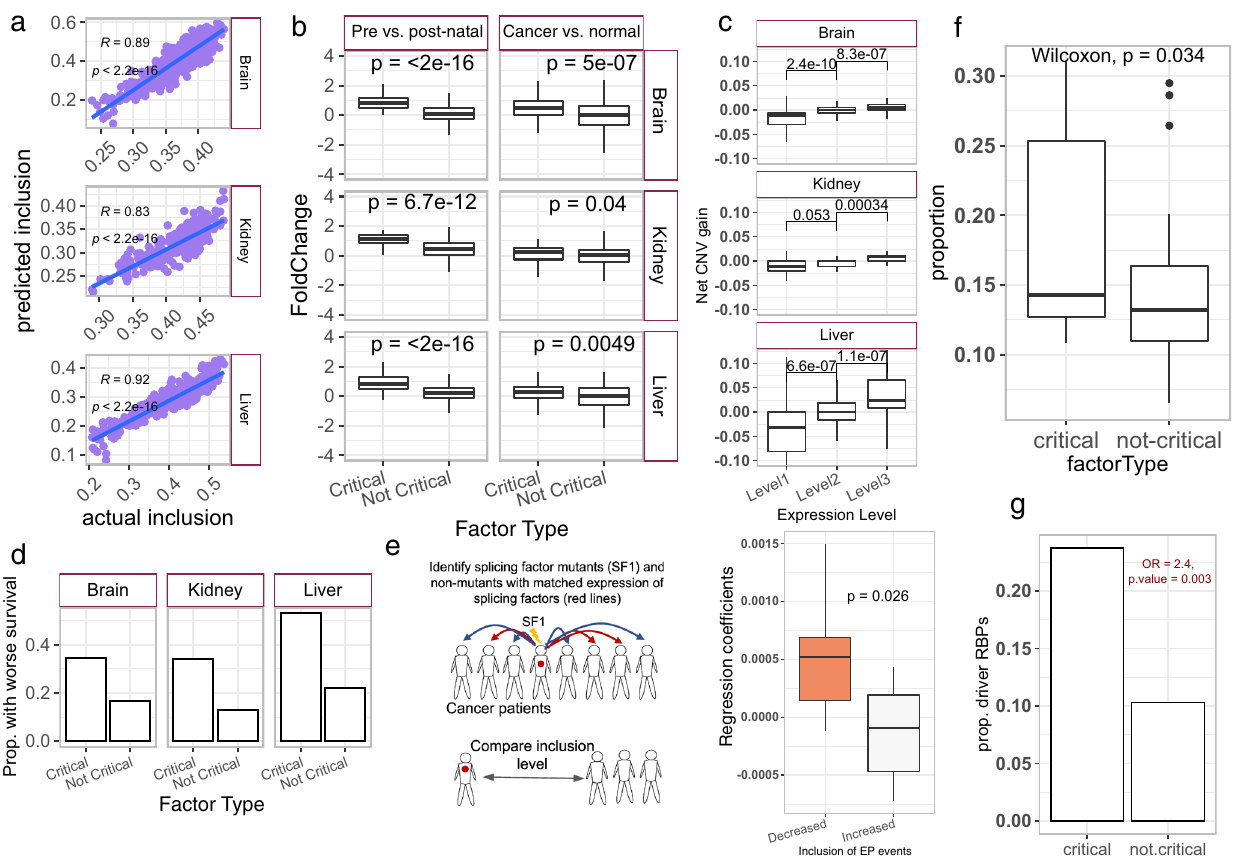
Fig. 4 | Splicing regulatory model of EP events reveals key splicing factors dysregulated in cancer. a Scatter plot of the actual and predicted median inclu- sion level of EP events across TCGA samples in a tissue-speci fi c cohort. Blue lines depictthebest fi ttinglinesbasedonlinearregressionbetweenactualandpredicted median inclusion of EP events. Pearson ’ s correlation coef fi cients and two-sided p- values are shown in the plots. b Boxplot distribution of fold-change of critical (n=119forbrain, n =167forliver,and n =45forkidney)andnon-critical( n =322for brain, n =274 for liver, and n =396 for kidney) splicing regulators of EP splicing eventsduringdevelopment(left)andincancer(right).Thecancertypesusedinthis analysis are LGG for brain, LIHC for liver, and KIRC for kidney. Two-sided p -values fromWilcoxon ’ stestareshown. c Boxplotsshowing distributionsof netCNVsgain ( “ Methods ” )incriticalsplicingfactorsinpatientsstrati fi edbasedontheexpression of the splicingfactors ( n =100for brainand liver and n =45 for kidney).Two-sided p -values from Wilcoxon ’ s test are shown. d Bar plots showing the proportion of criticalandnon-criticalsplicingfactorswhichresultinthepoorprognosisofcancer patients in three cancer types. The odds ratio (OR) and FDR-adjusted two-sided p - values (pval) shown next to each plot are calculated using Fisher ’ s exact test by comparing the proportion of critical and non-critical splicing factorshaving worse prognosisincancerpatients.Worseprognosiswasde fi nedbasedon>1hazardratio